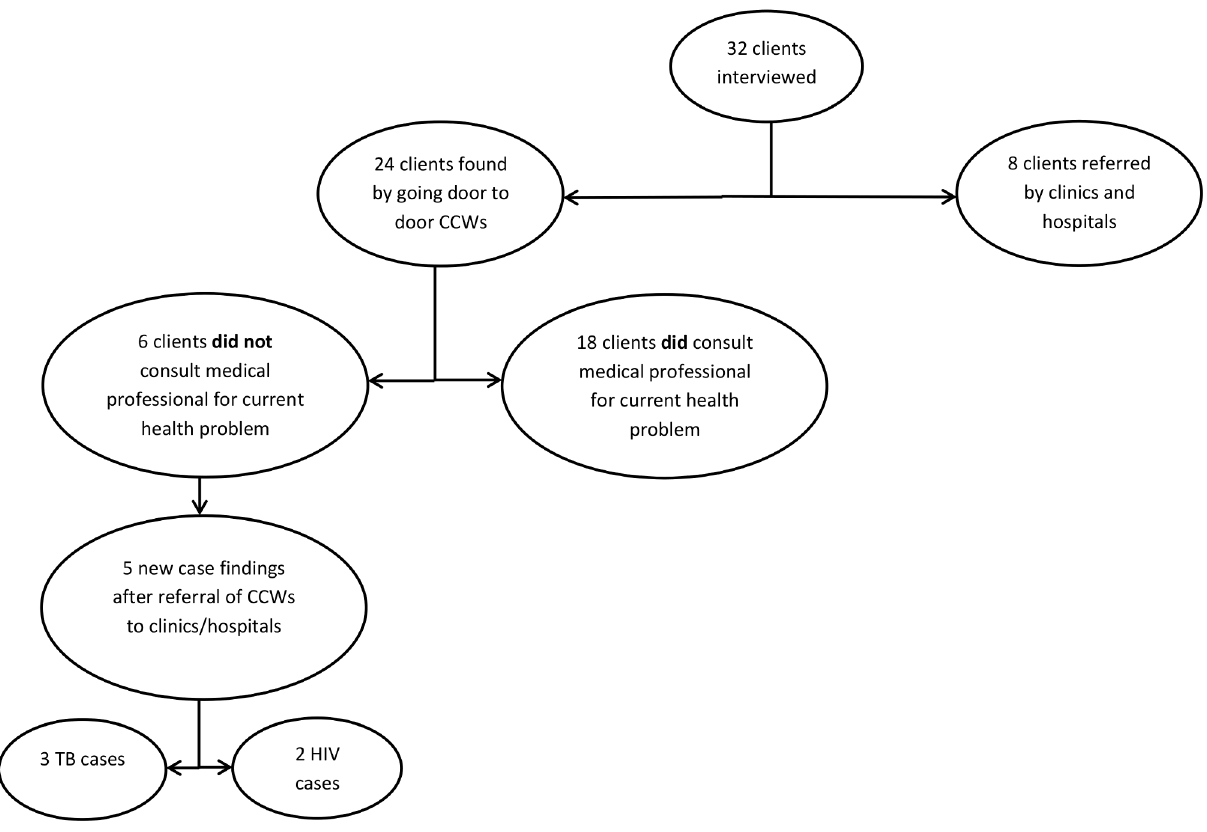
Figure 1. Referral practices between the health care system and home-based care programs. This figure shows client enrollment in HBC programs, showing the low referral rate of patients from health care facilities to HBC programs, especially in comparison to the total number of clients receiving medical care and their potential need of HBC.